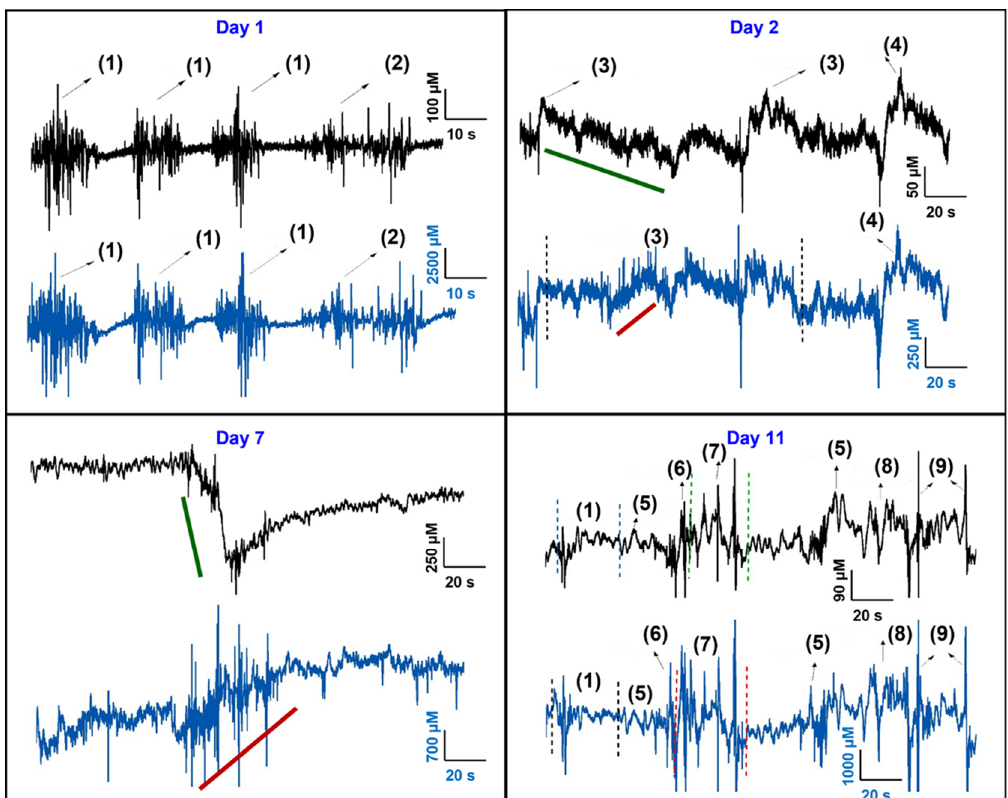
Figure 6. Simultaneous GLU (black curve) and GABA (blue curve) in vivo recordings at different days in Rat 1. The number legends represent: (1) walking, (2) sniffing, (3) Grinding Teeth, (4) moving, (5) external sound, (6) head flick, (7) climbing, (8) head movement, (9) body flick. Day 1 is the day of surgery. The chemical changes are correlated to the rat behavior. Amperometry: +0.7 V vs. Ag/AgCl wire.